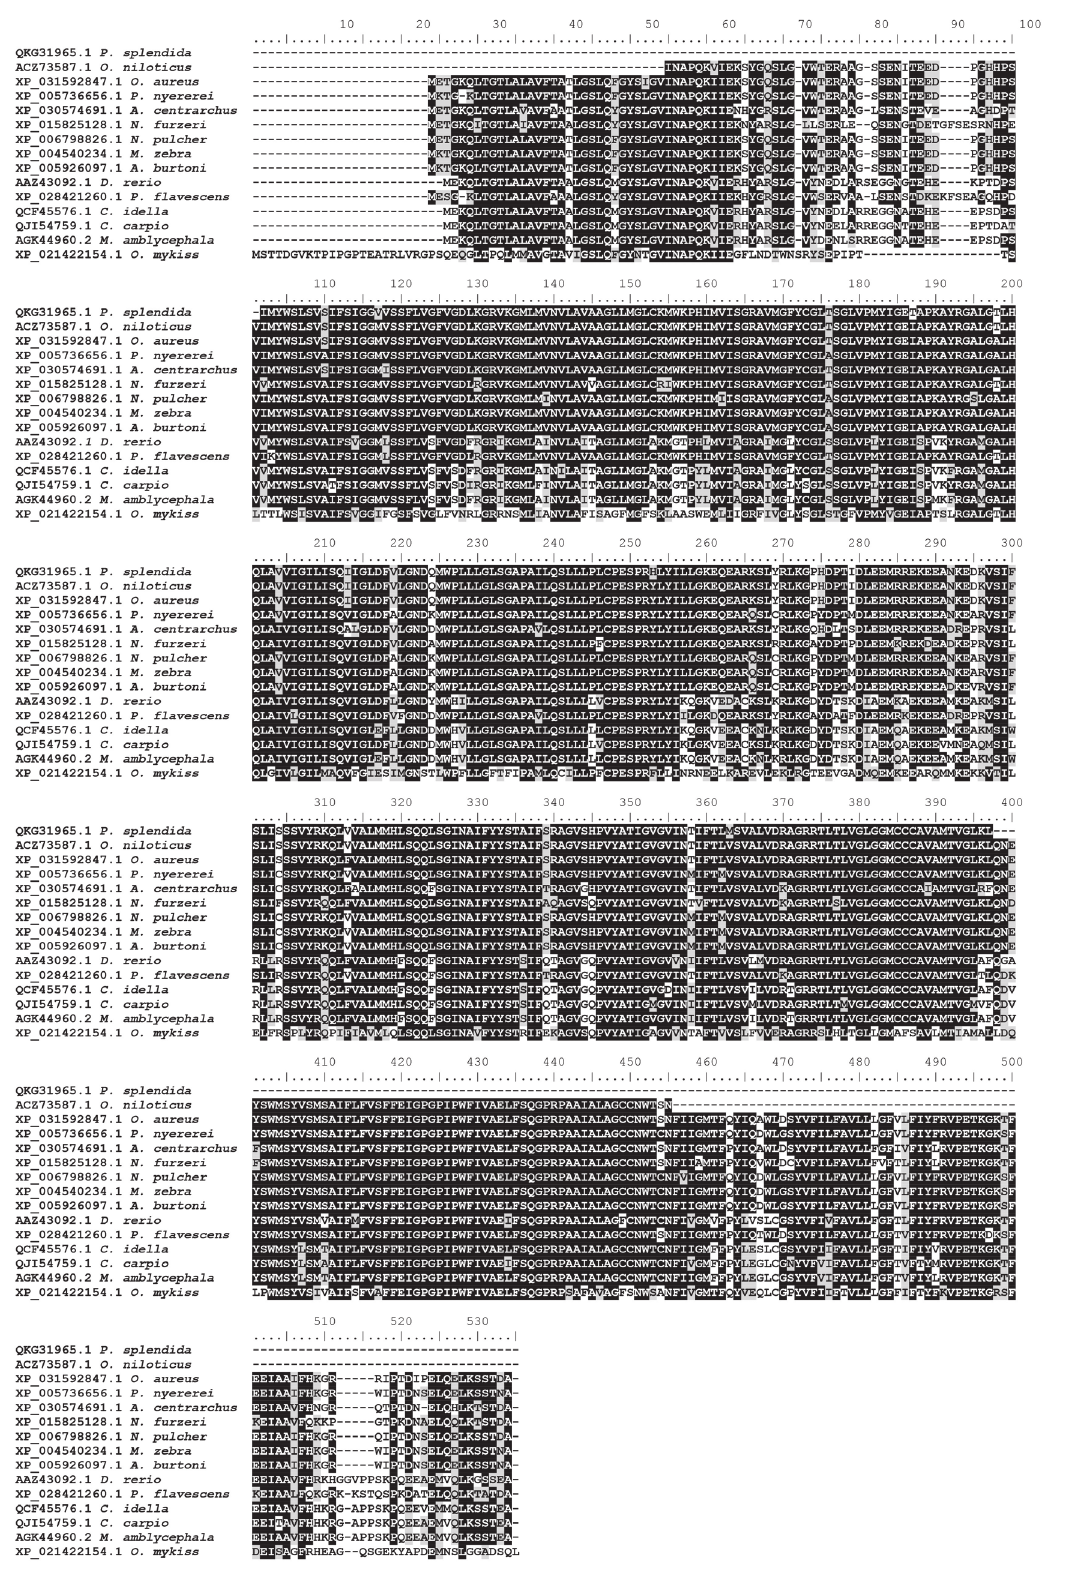
FIGURE 2 | Amino acid sequence of glut2 in Petenia splendida aligned with other species other species of teleost fish. Identical amino acids are presented in black, and the high and less conserved amino acids are presented in gray and period,